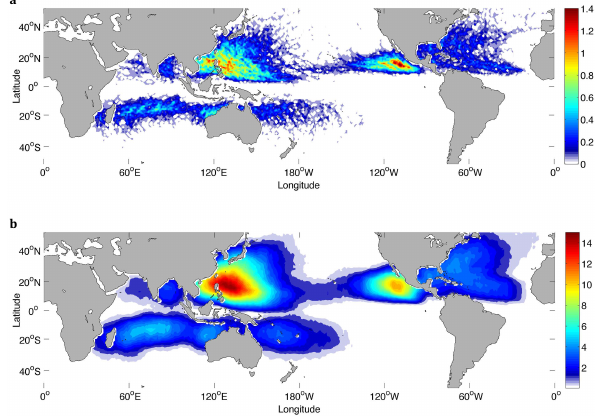
Figure 7. Frequencies of tropical cyclones per year affecting 1 ◦ by 1 ◦ grid boxes, when the TC-affected region is assumed to be (a) ± 1 ◦ from the track center and (b) ± 8 ◦ from the track center.